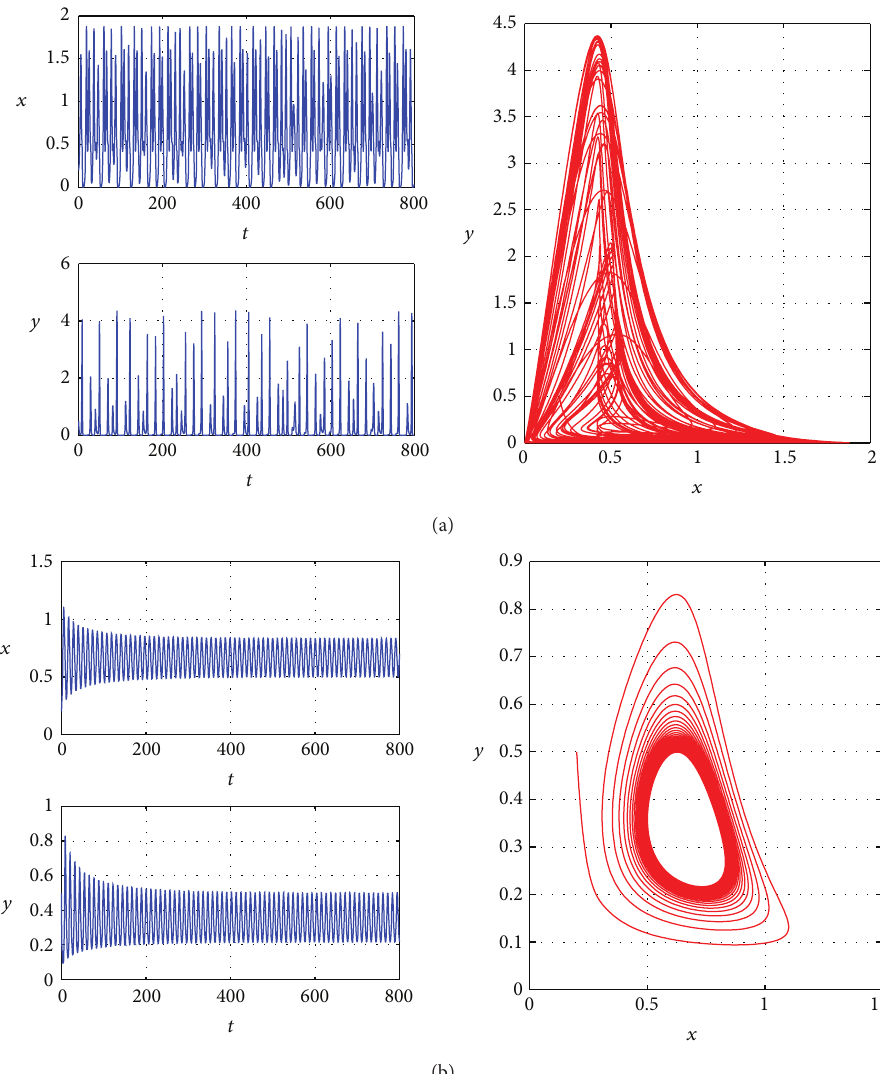
Figure 5: Waveform plot and phase plot of system (3) with 𝜏 = 1.5 : (a) 𝑘 1 = 𝑘 2 = 0 ; (b) 𝑘 1 = −0.2 , 𝑘 2 = −0.5 .